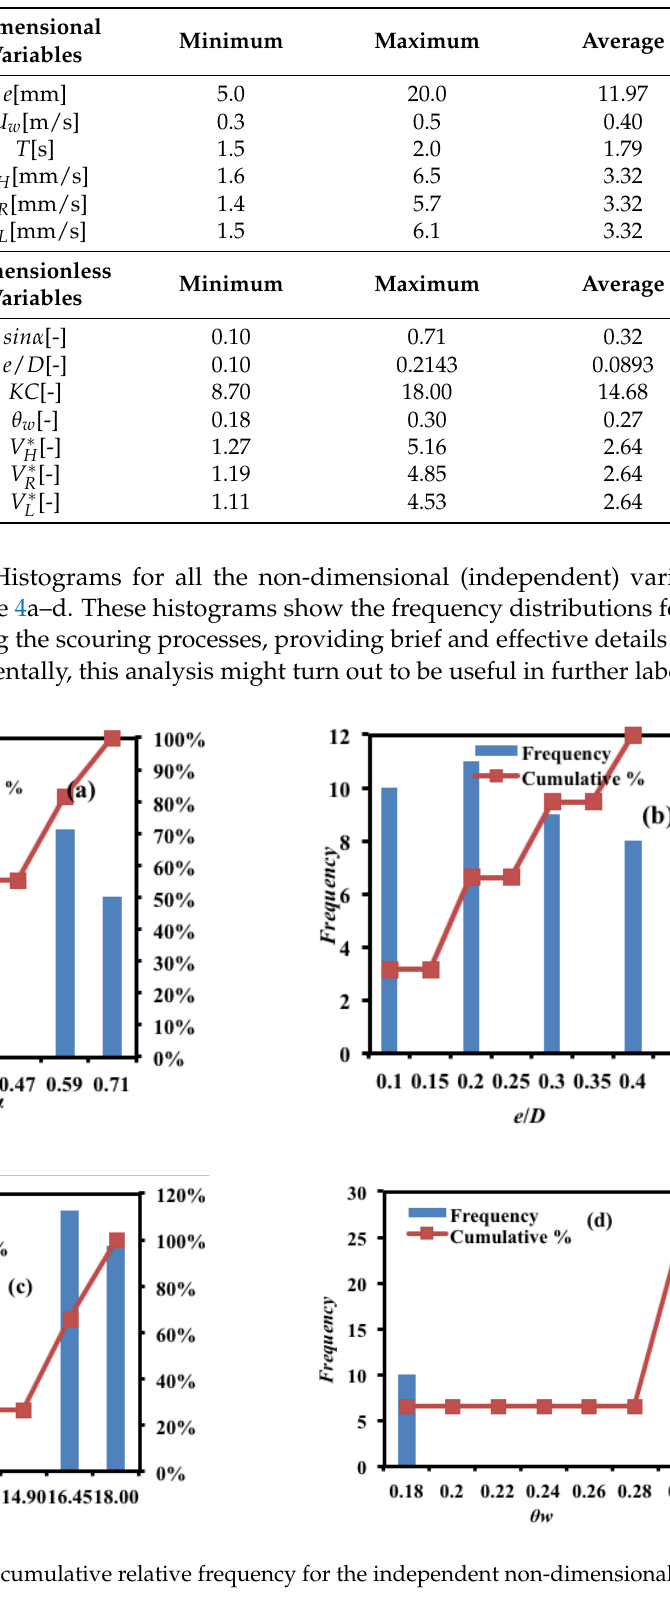
Table 1. Basic statistical properties of the variables under study for AI modeling.